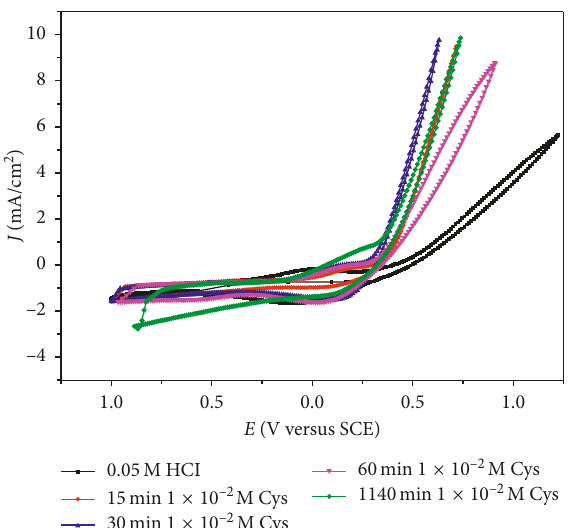
Figure 5: Cyclic voltammogram of brass in a 0.05M HCl solution after immersion in 1 · 10 − 2 M cysteine solution for various periods of time (15, 30, 60, and 1140min; scan rate: 10mV/s).